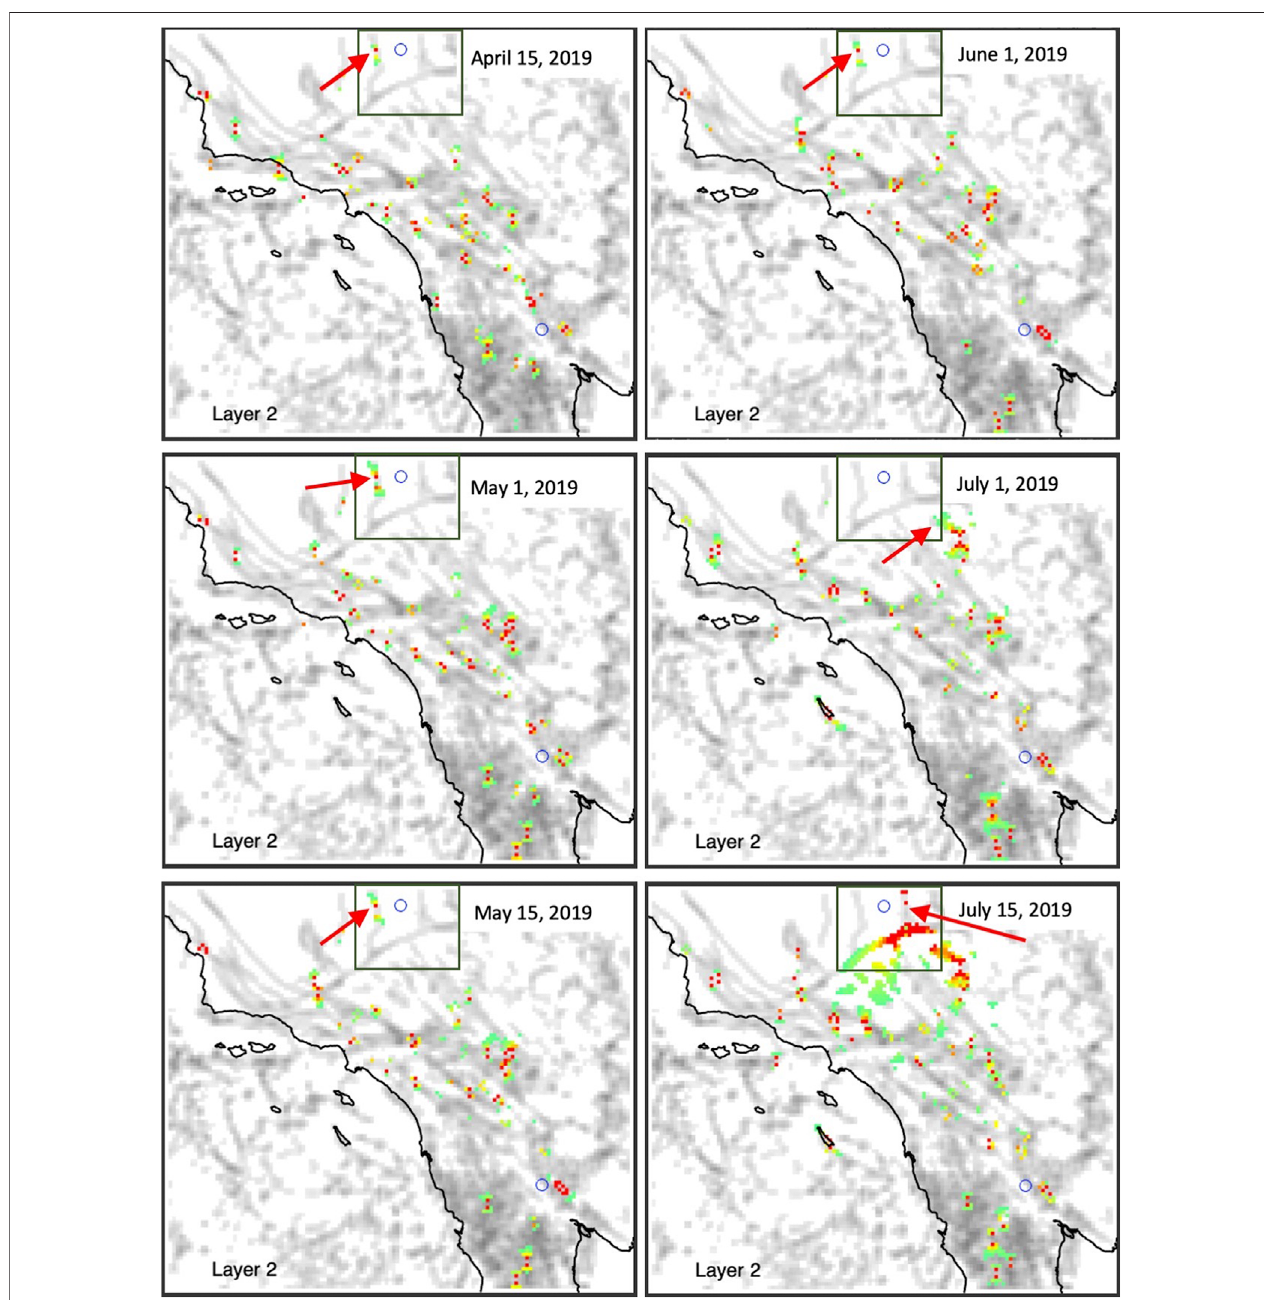
FIGURE 10 | Strength parameter patterns for layer 2, plotted for a series of instants from April to June 2019. Grayscale corresponds to initial normalized damage, while colored spots indicate anomalous model cells with elevated D. Red arrows point at anomaly locations within the epicentral area (shown by dark-green rectangle), traced in the subsequent analysis (as demonstrated in Figure 11